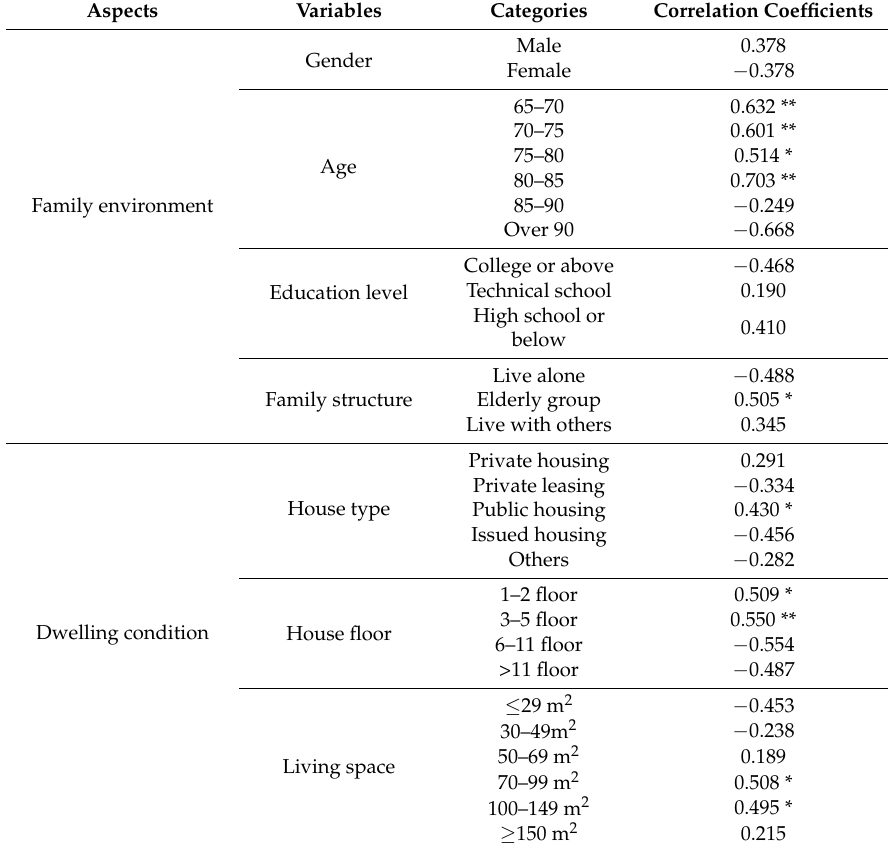
Table 1. Correlation analysis between existing beds and each percentage of categories at